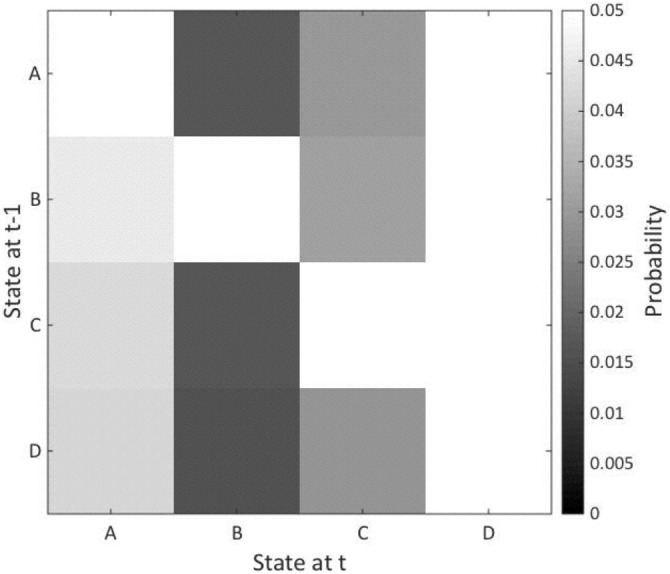
Microstate transition probability. The figure shows the probability of transition from one microstate to another with the results of the patients subtracted from the healthy controls. The vertical axis represents states at time point −1 and the horizontal axis shows states at time 1. The microstates are indicated A–D. No significant between-group differences were noted.